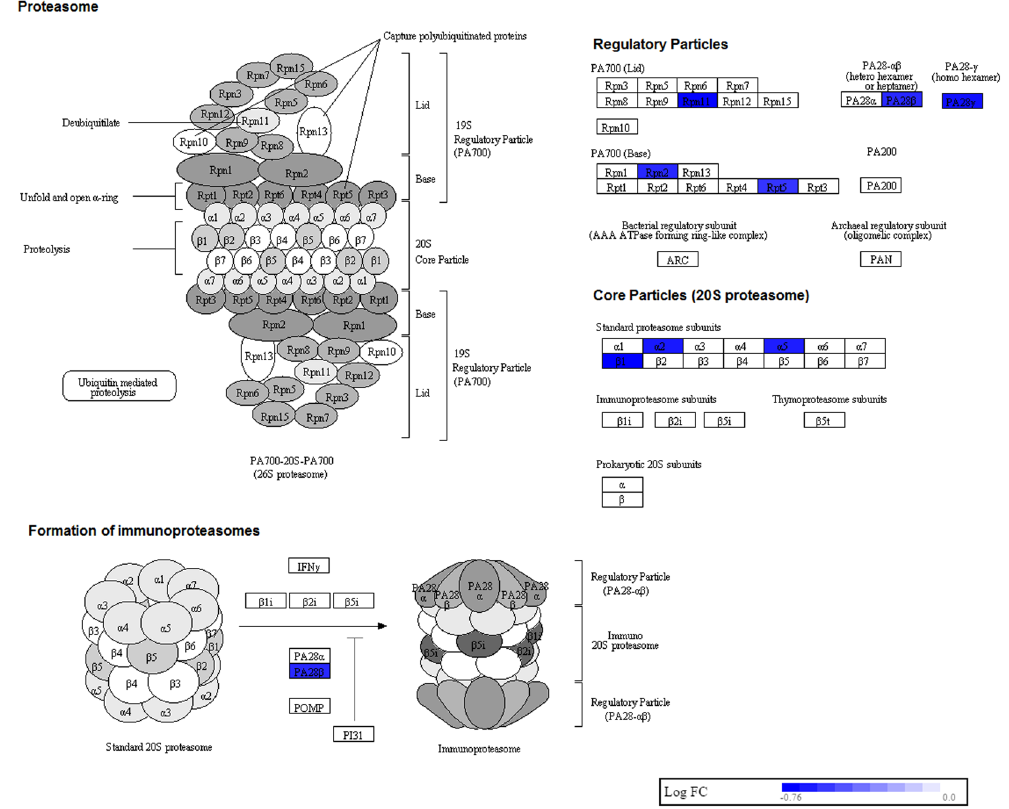
Figure 5. Proteasome in sarcoidosis monocytes. Graphic illustration of pathway analysis of DE (log 2 -fold change with FDR < 0.05) genes related to proteasome and immunoproteasome in sarcoidosis monocytes. The pathway diagram is overlaid with the computed perturbation of each gene. The perturbation accounts both for the gene’s measured fold changes and for accumulated perturbation propagated from any upstream genes (accumulation). Note: Several genes involved in regulatory and core particles and immunoproteasomes were downregulated (blue) in sarcoidosis